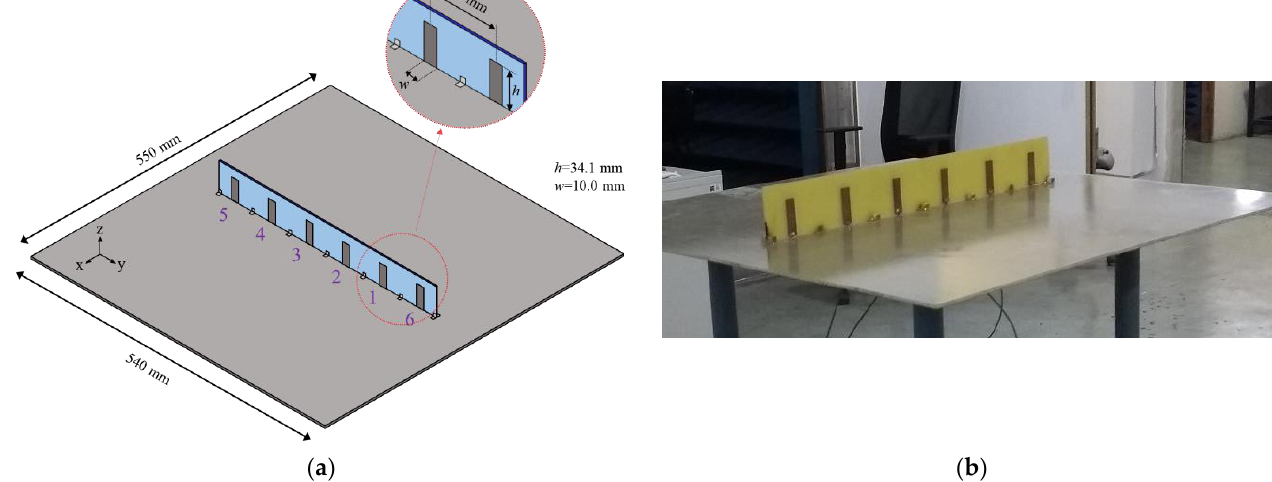
Figure 4. Printed monopole array: ( a ) Geometry dimensions; ( b ) Prototype.